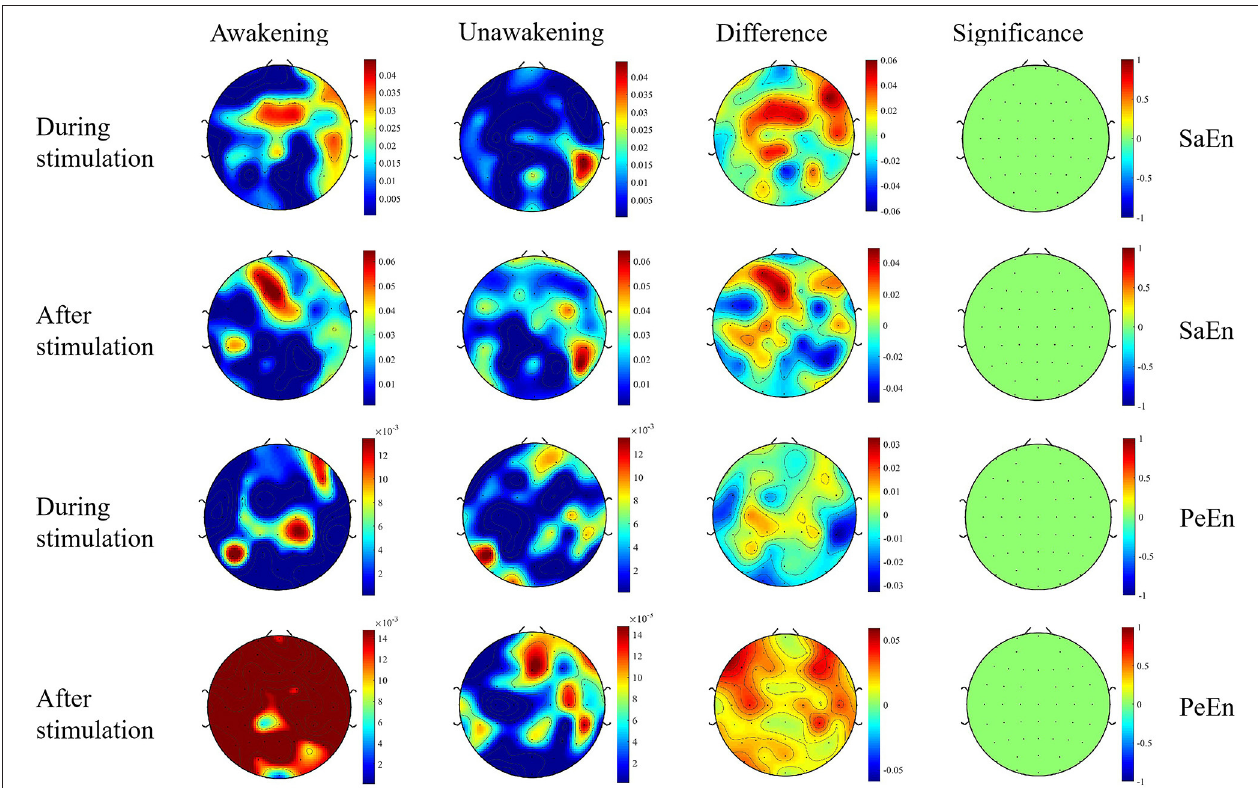
FIGURE 5 | Topography based on SaEn and PeEn. Significance is the statistical P -value; the greater the absolute value of P , the greater the difference. The first column and second column are the results of comparisons before and during (or after) stimulation in the awakening group and unawakening group, respectively. The third column is a comparison between the awakening and unawakening groups. The color bars in the first three columns represent the actual values of the entropy; the color bar in the fourth column represents the statistical value t. SaEn, sample entropy; PeEn, permutation